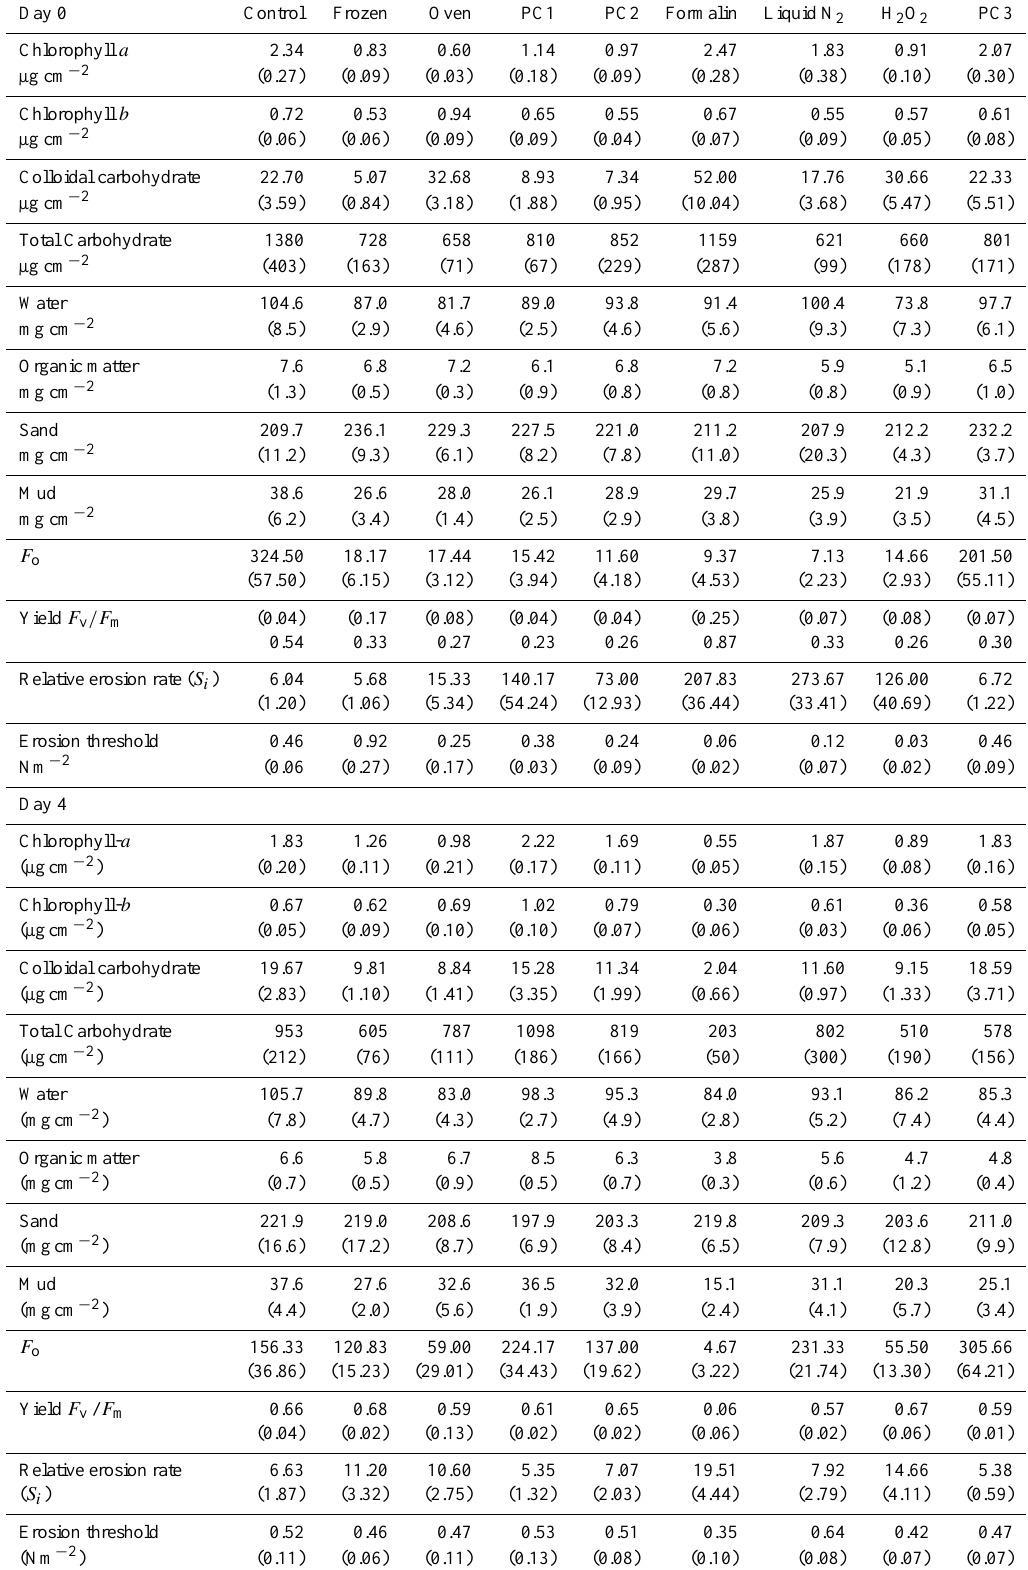
Table 2. Means and (SE) of the 12 variables for each treatment, for 0, 4 and 15 days after treatment. Day